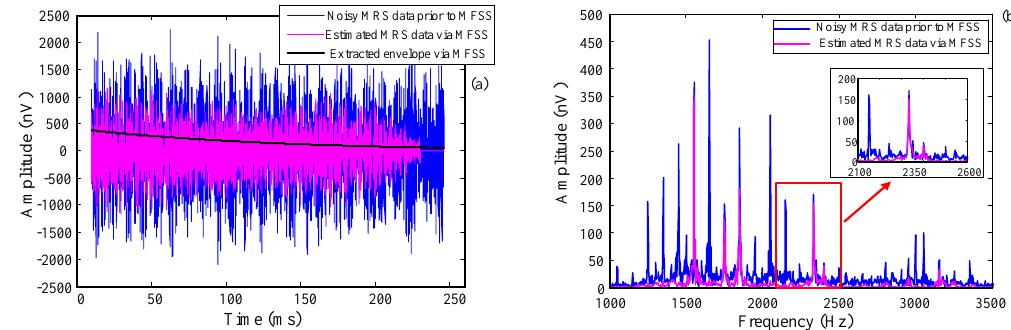
Figure 11. Noise reduction result of field MRS data by MFSS under the condition of short window length and small frame shift. ( a ) The waveform comparison and the extracted envelope; ( b ) the spectral amplitude comparison.